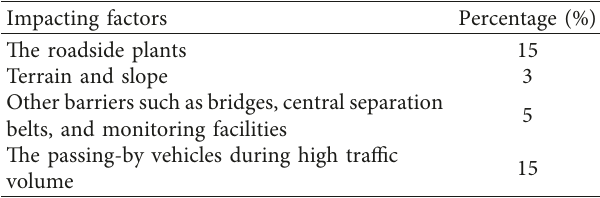
Table 1: The impacting factors on the occlusion of traffic